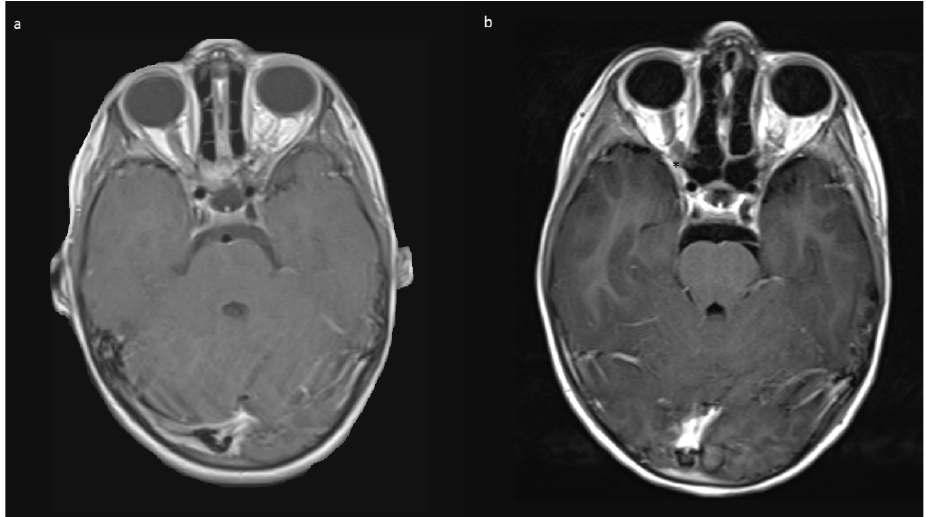
Figure 7. Exemplary MR imaging follow-up of a small contralateral right-sided prechiasmatic optic nerve glioma ( a ) 12 months postoperatively; ( b ) 60 months postoperatively.